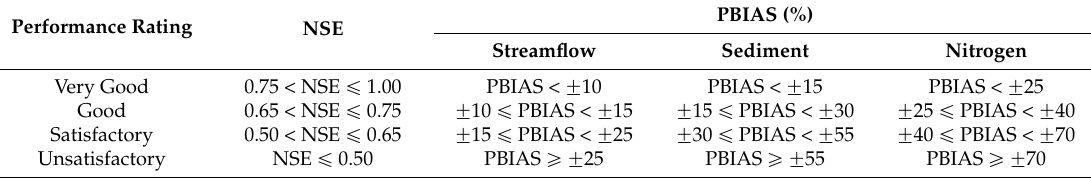
Table 2. Quantitative criteria categorized by the General Performance Ratings